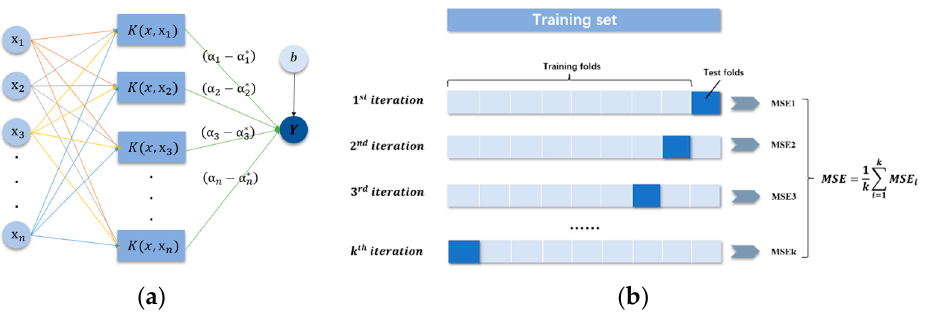
Figure 7. ( a ) Schematic view of the SVR model and ( b ) k-fold cross-validation approach.